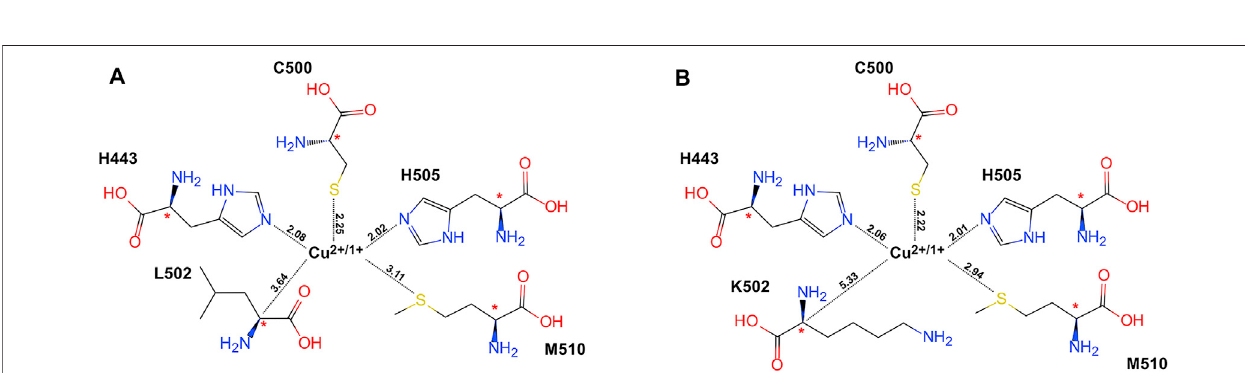
Frontiers in Bioengineering and Biotechnology |